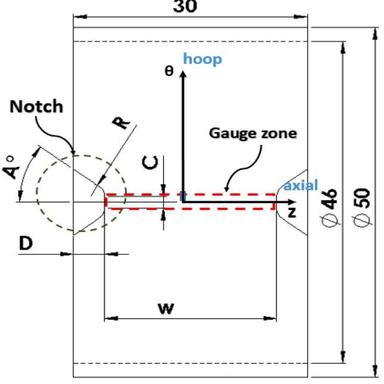
Engineering drawing of RHPST specimen with definition of the geometric dimensions.